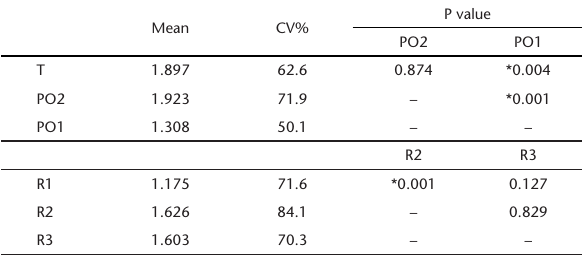
Table 1. Wilcoxon pairwise test results comparing group size esti- mates (T, PO2 and PO1) and ratios (R1, R2 and R3). See text for descriptions. * Significant values ( a =